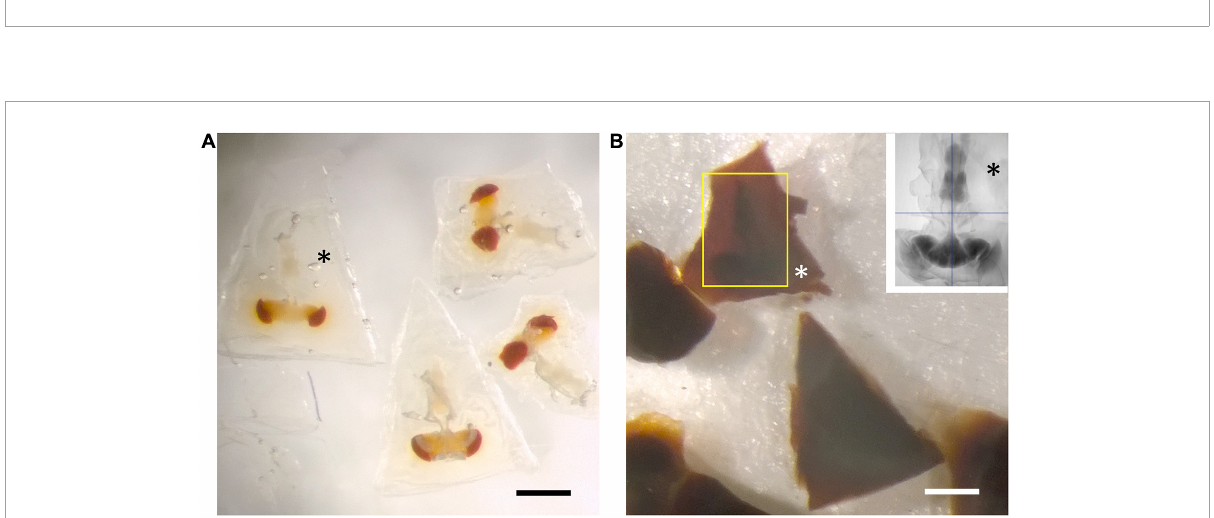
FIGURE4 BSA coating of dissected brain. (A) Fixed specimens in trapezoidal blocks after coating with BSA. (B) Osmication and staining with metal salts darkens the BSA, but leaves the brain’s outline still visible (yellow rectangle). Different zones in the surrounding BSA reveal successive additions of the cross-linked protein. Inset: soft X-ray tomogram of a single CNS. Asterisks in all images show the BSA coat in different stages of processing. All scale bars: 500 µ m.